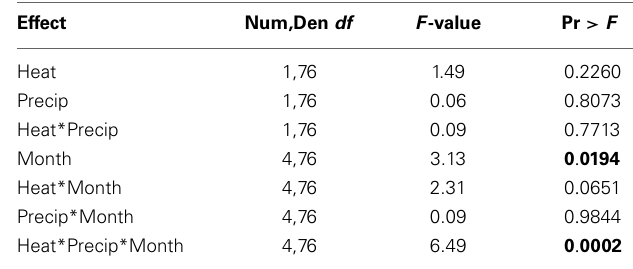
Table 3 | Statistical results of the effects of the climate treatments ( + heat and + precip), month since the project began, and their interactions on the change in tall fescue endophyte infection frequency from the initial harvest June 1,